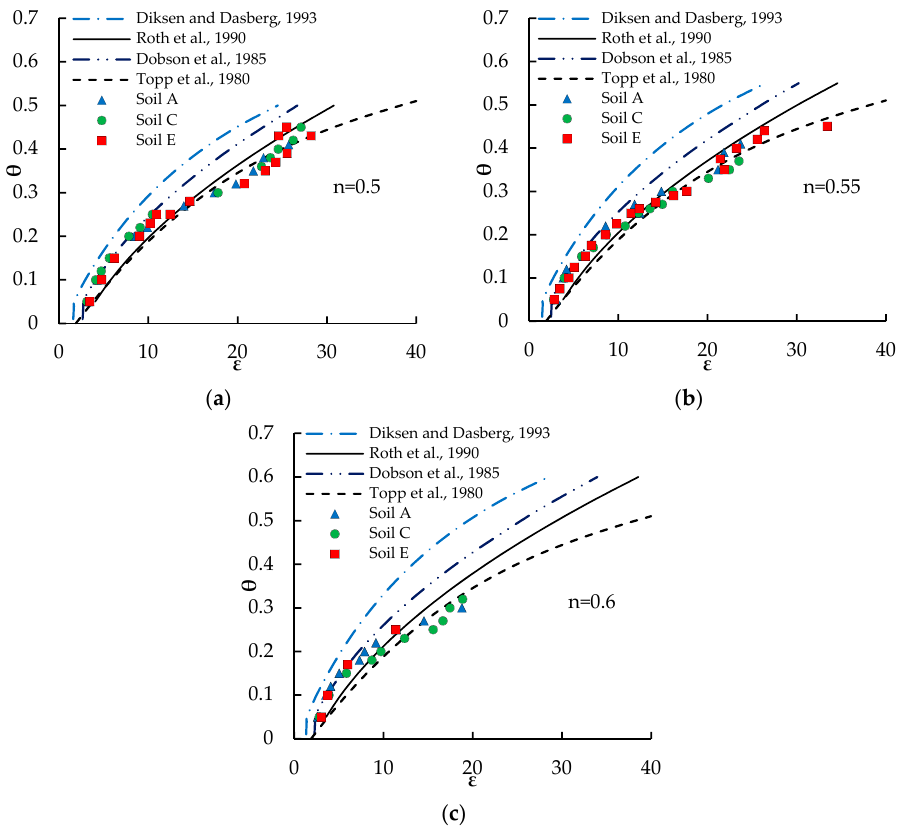
Figure 4. Experimental data for various porosities compared with calibration relationships from literature. ( a ) n = 0.5; ( b ) n = 0.55; ( c ) n = 0.6. Table 5. Best fitting parameters of the four-phase dielectric mixing model by Dobson et al. [36].